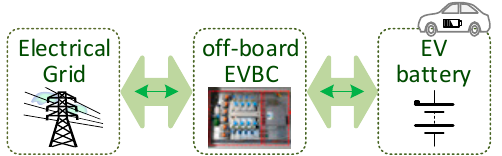
Figure 14. Integration of an off-board EVBC into the electrical power grid for G2V and V2G operation modes.